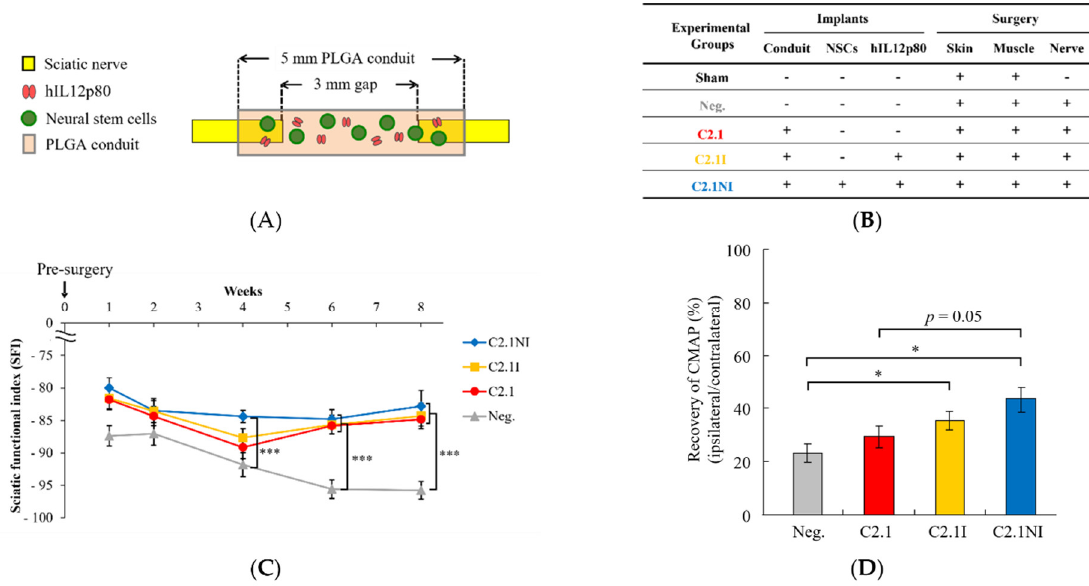
Figure 5. Summary of the various treatments and functional assessments for the implantation of PLGA conduits with human IL12p80 and NSCs in the sciatic nerve injury B6 mouse model. ( A ) The illustration of a micro/nanohybrid-structured PLGA nerve conduit C2.1, which was filled with hIL12p80, matrix gel, and NSCs. ( B ) The summary table of the different treatment groups with or without implantation of Conduit 2.1, NSCs, and hIL12p80, with or without the surgery of skin, muscle, and nerve, and with or without the nerve transection in B6 mouse model. ( C ) SFI was calculated to assess functional recovery. The C2.1, C2.1I, and C2.1NI groups showed a significant difference compared with the Neg. group in statistical analysis in the sixth and eighth weeks. In the fourth week, only the C2.1NI showed a significant difference compared with the Neg. group. ( D ) The percentage of the Recovery of CMAP in the different treatment groups. All data are presented as mean ± SEM (n = 5 in C2.1, C2.1I, and C2.1NI groups, and n = 6 in Neg. group). Statistical differences are indicated by * p < 0.05, and *** p < 0.001.